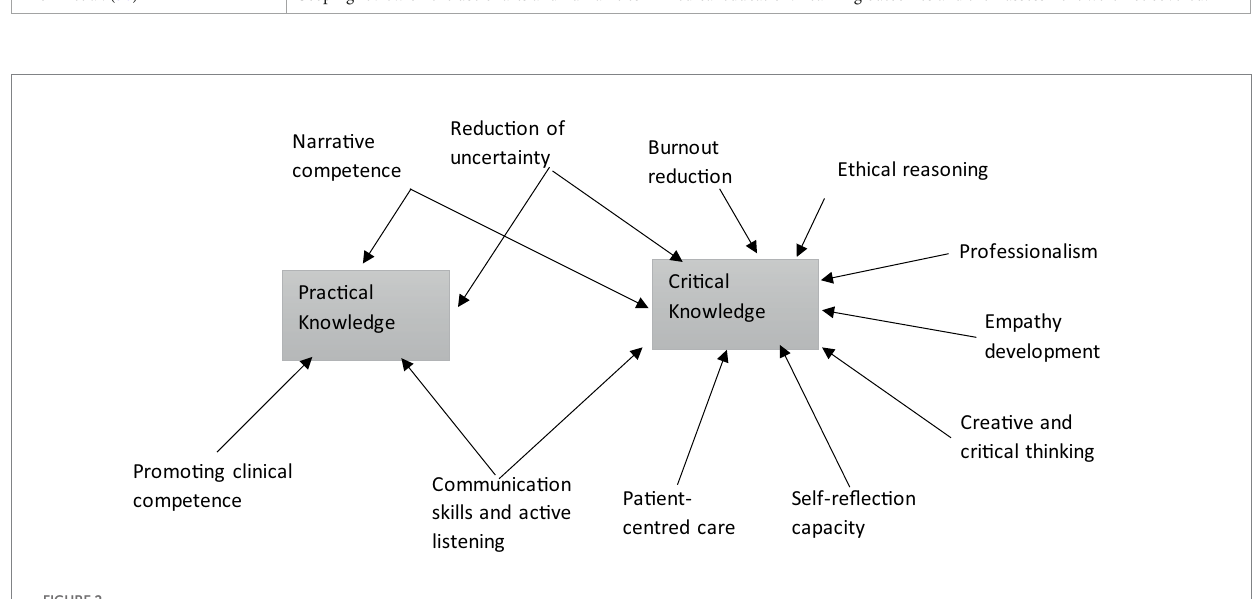
FIGURE 2 Correlation between medical humanities’ learning outcomes and types of knowledge (Spain,